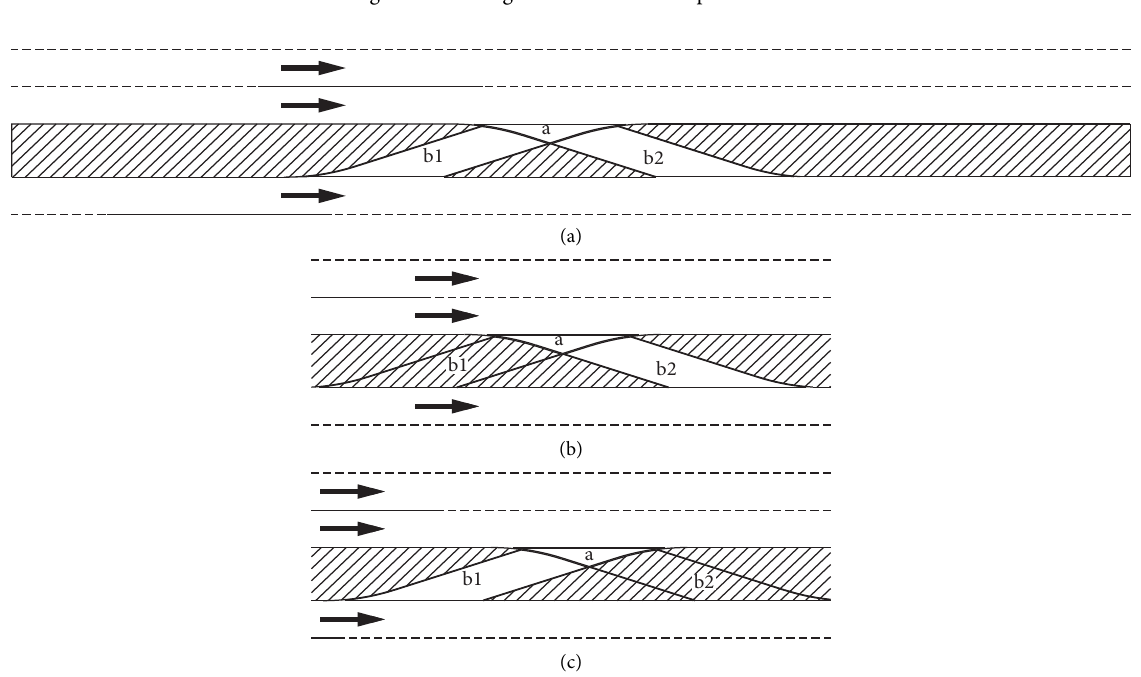
Figure 2: The geometric design of switchable ramp and two of its forms.